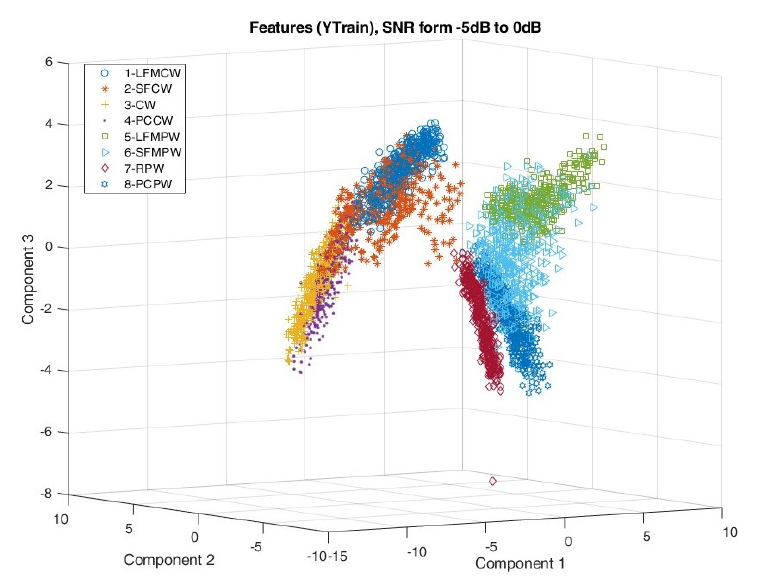
Figure 15. First three components after feature dimension reduction using PCA for SNR in range